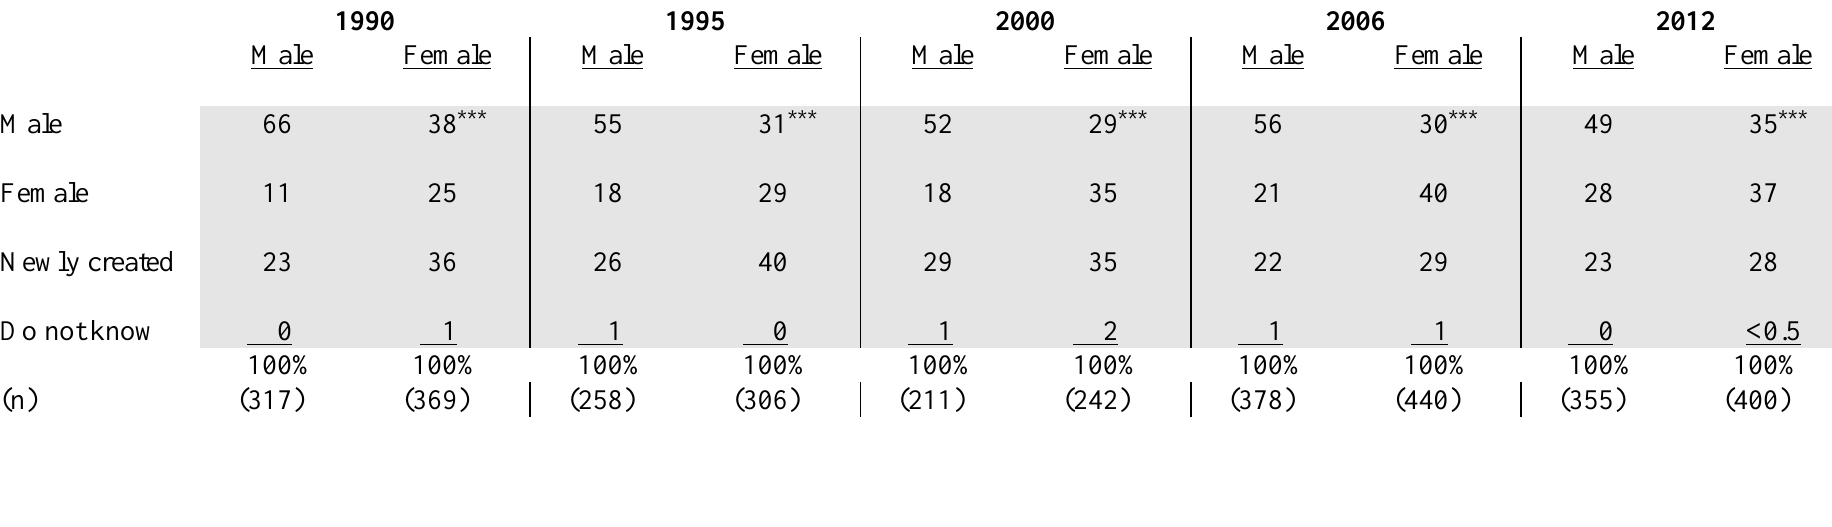
Table 25. Gender of Predecessor